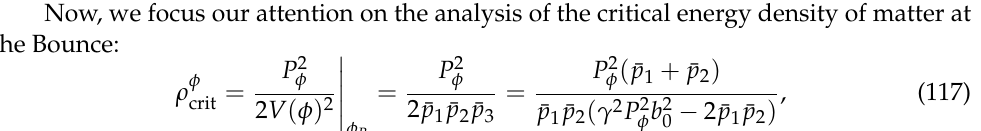
Figure 7. Polymer trajectory of the Universe volume V = replaces the classical singularity of the Bianchi I